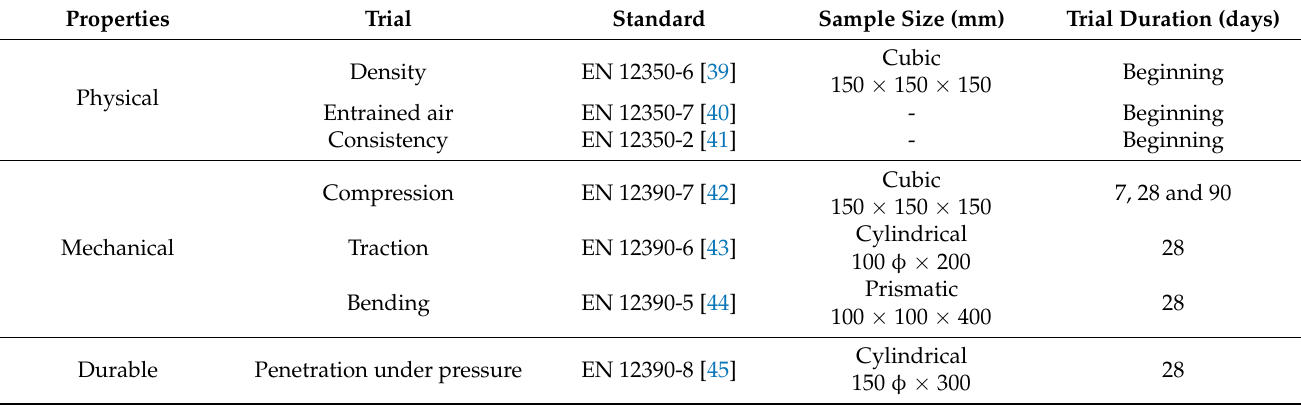
Table 4. The concrete properties analysed in fresh and hardened states.